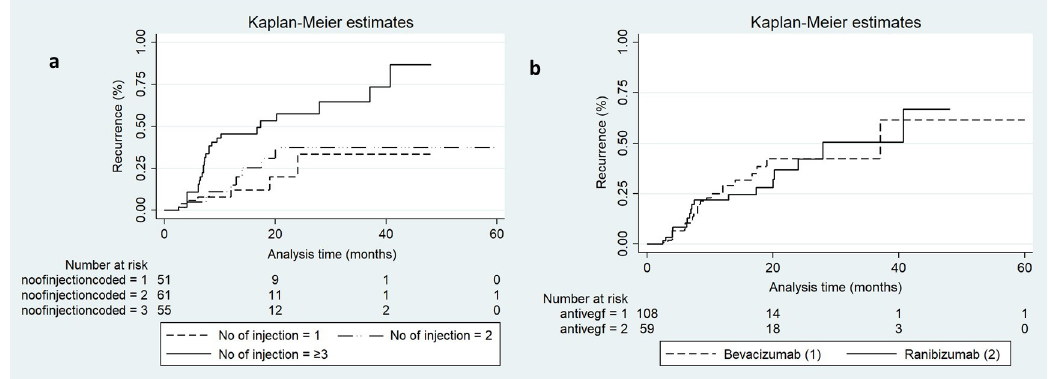
Fig 1. (a) Shows the survival function curve for the number of injections, depicting a steady increase in recurrence rate with the number of injections. (b) Shows the survival function curve for the bevacizumab and ranibizumab, depicting no difference in the recurrence rate between the two groups.